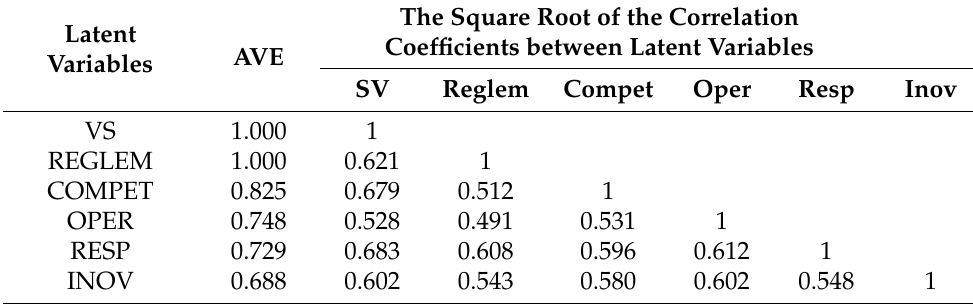
Table 4. Correlation matrix of the latent variables.